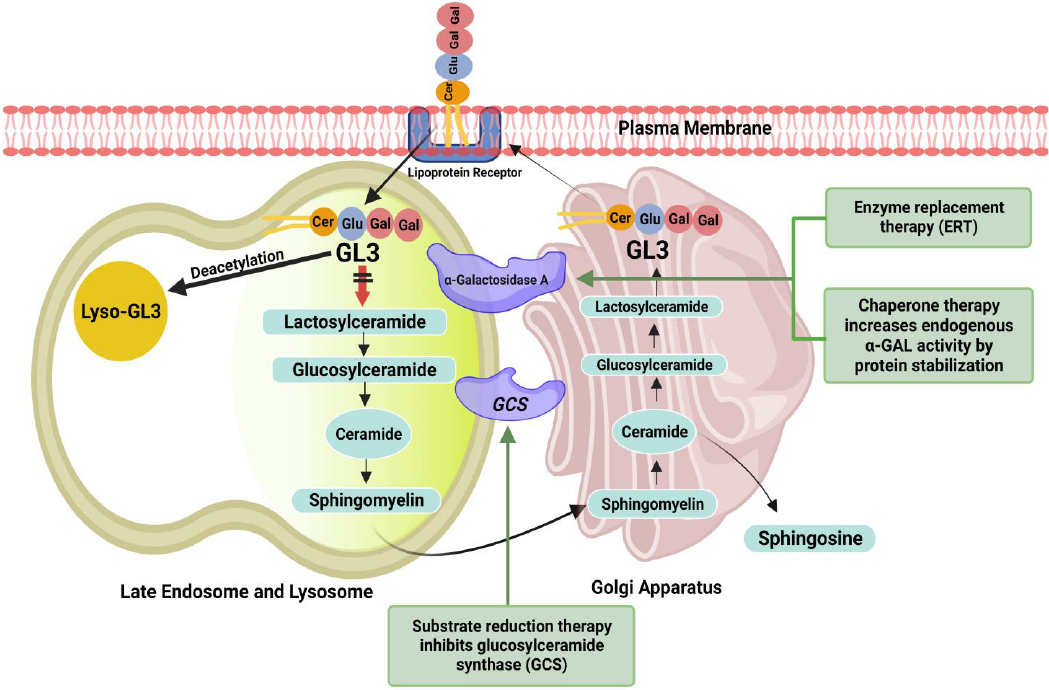
Figure 1. Overview of the ceramide pathway and therapeutic targets. ERT replaces deficient endoge- nous enzyme with recombinant enzyme (Agalsidase- α or Agalsidase- β ). Chaperone (migalastat) binds reversibly to and stabilizes amenable gene variants of α -GAL, thereby facilitating proper trafficking of the enzyme to lysosomes and increasing enzyme activity. Substrate reduction therapy (lucerastat or venglustat) causes inhibition of glucosylceramide synthesis and reduces the accumula- tion of glycosphingolipids, including glucosylceramide and globotriaosylceramide (GL3). Table 2. Available and investigational drugs for the treatment of FD with their mechanism of action, route of administration, and physiological effects. α - galactosidase A (α -GAL), glucosylceramide (GL1), globotriaosylceramide (GL3).